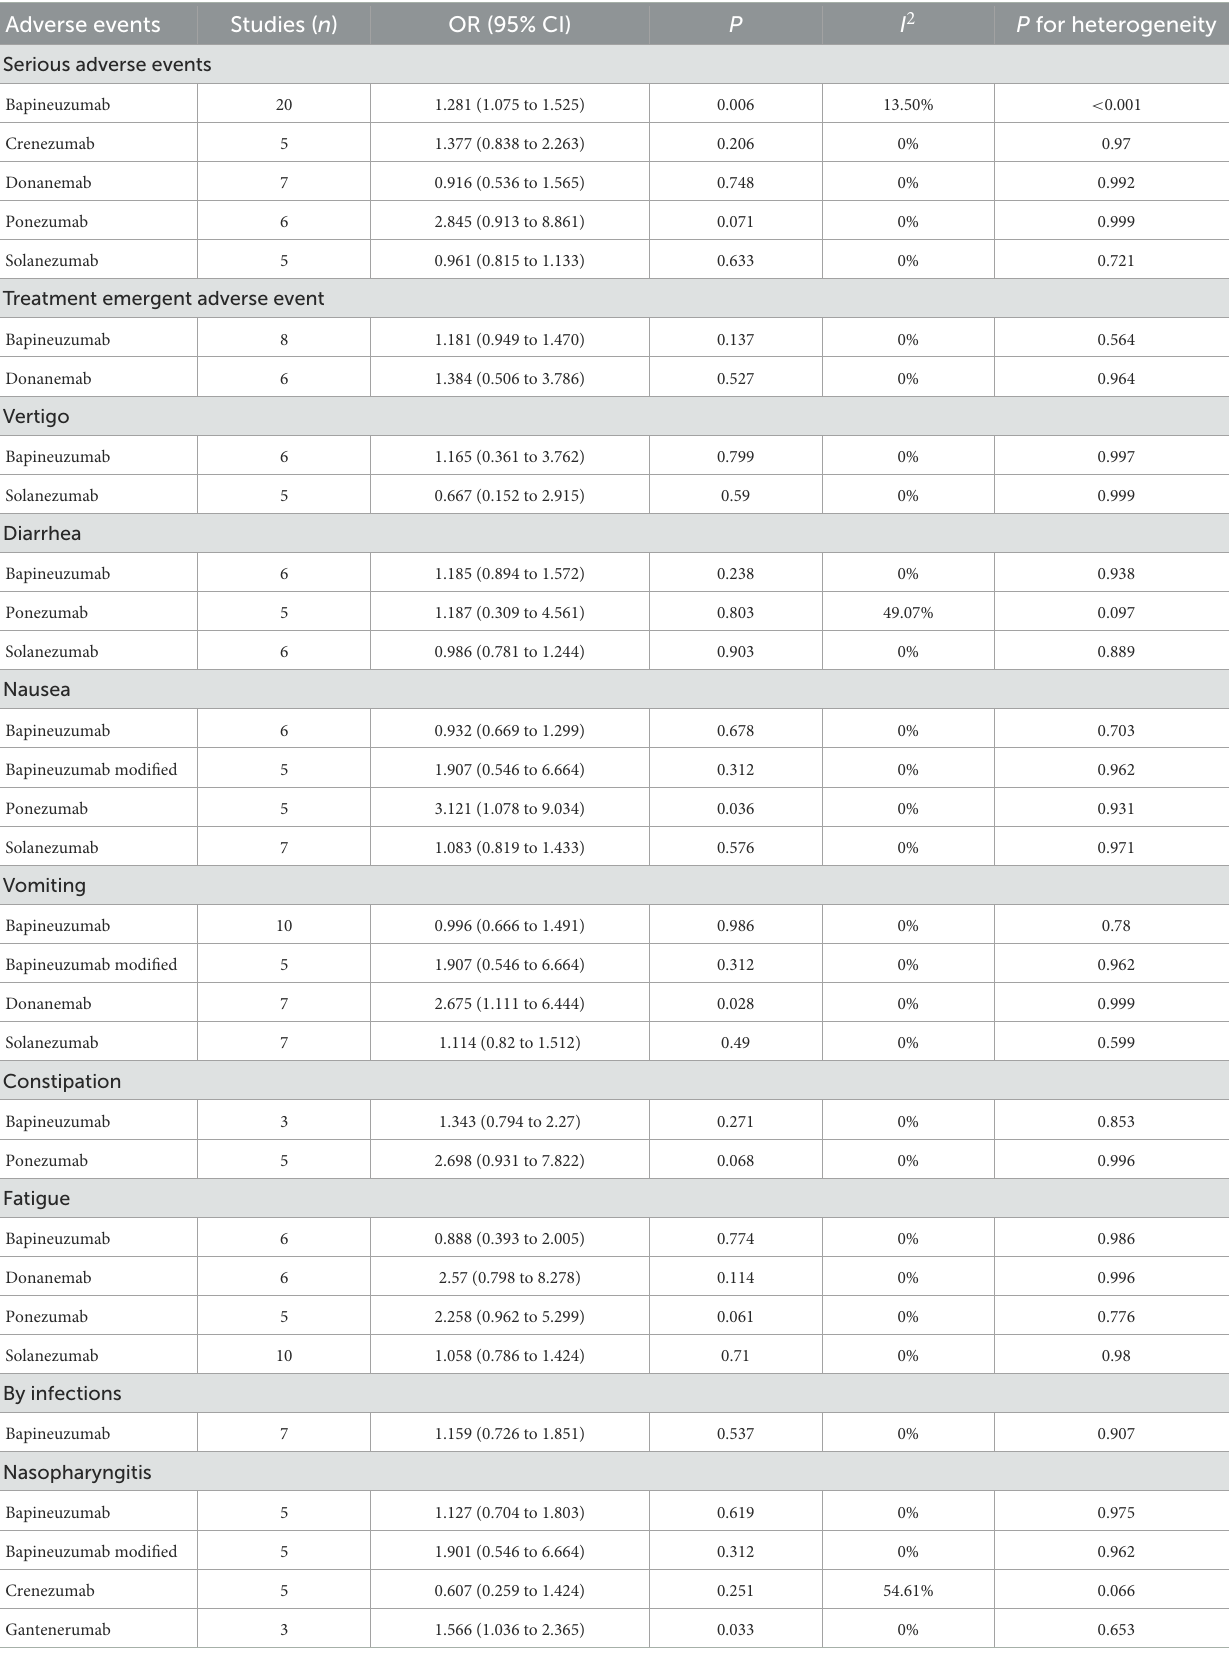
TABLE 4 Common adverse events associated with monoclonal antibodies against A β in the treatment of mild or moderate AD. Adverse events Studies ( n ) OR (95% CI) P I 2 P for